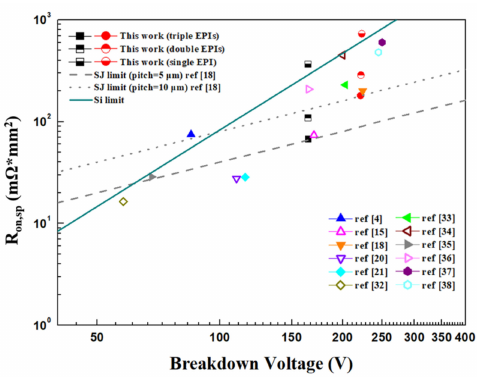
Figure 12. The comparison of R on,sp against V BR relationship of middle-voltage SGT structures, super junction devices, ideal silicon limit and super junction (SJ) limit (cell pitch = 5 and 10 µ